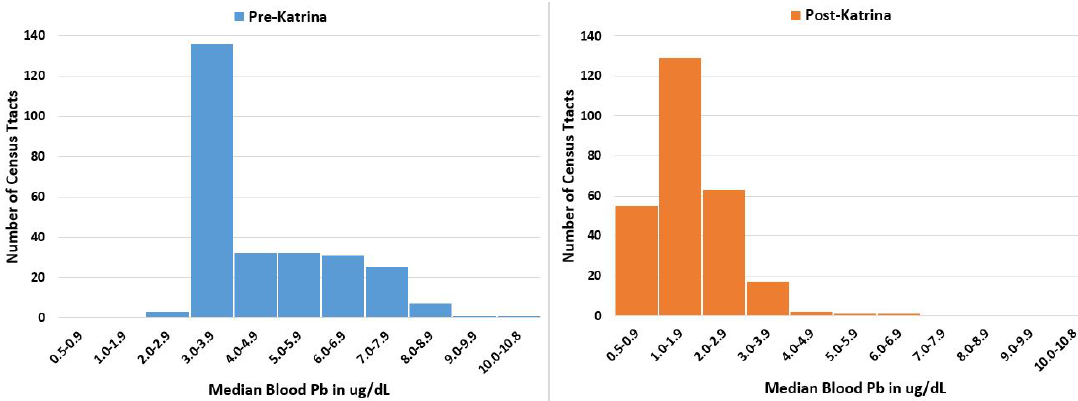
Figure 3. Histograms of children’s (≤6 years old) median blood lead levels before and after Hurricane Katrina. N = 268. Not all census tracts had sufficient numbers of tested children for matching between the two surveys.